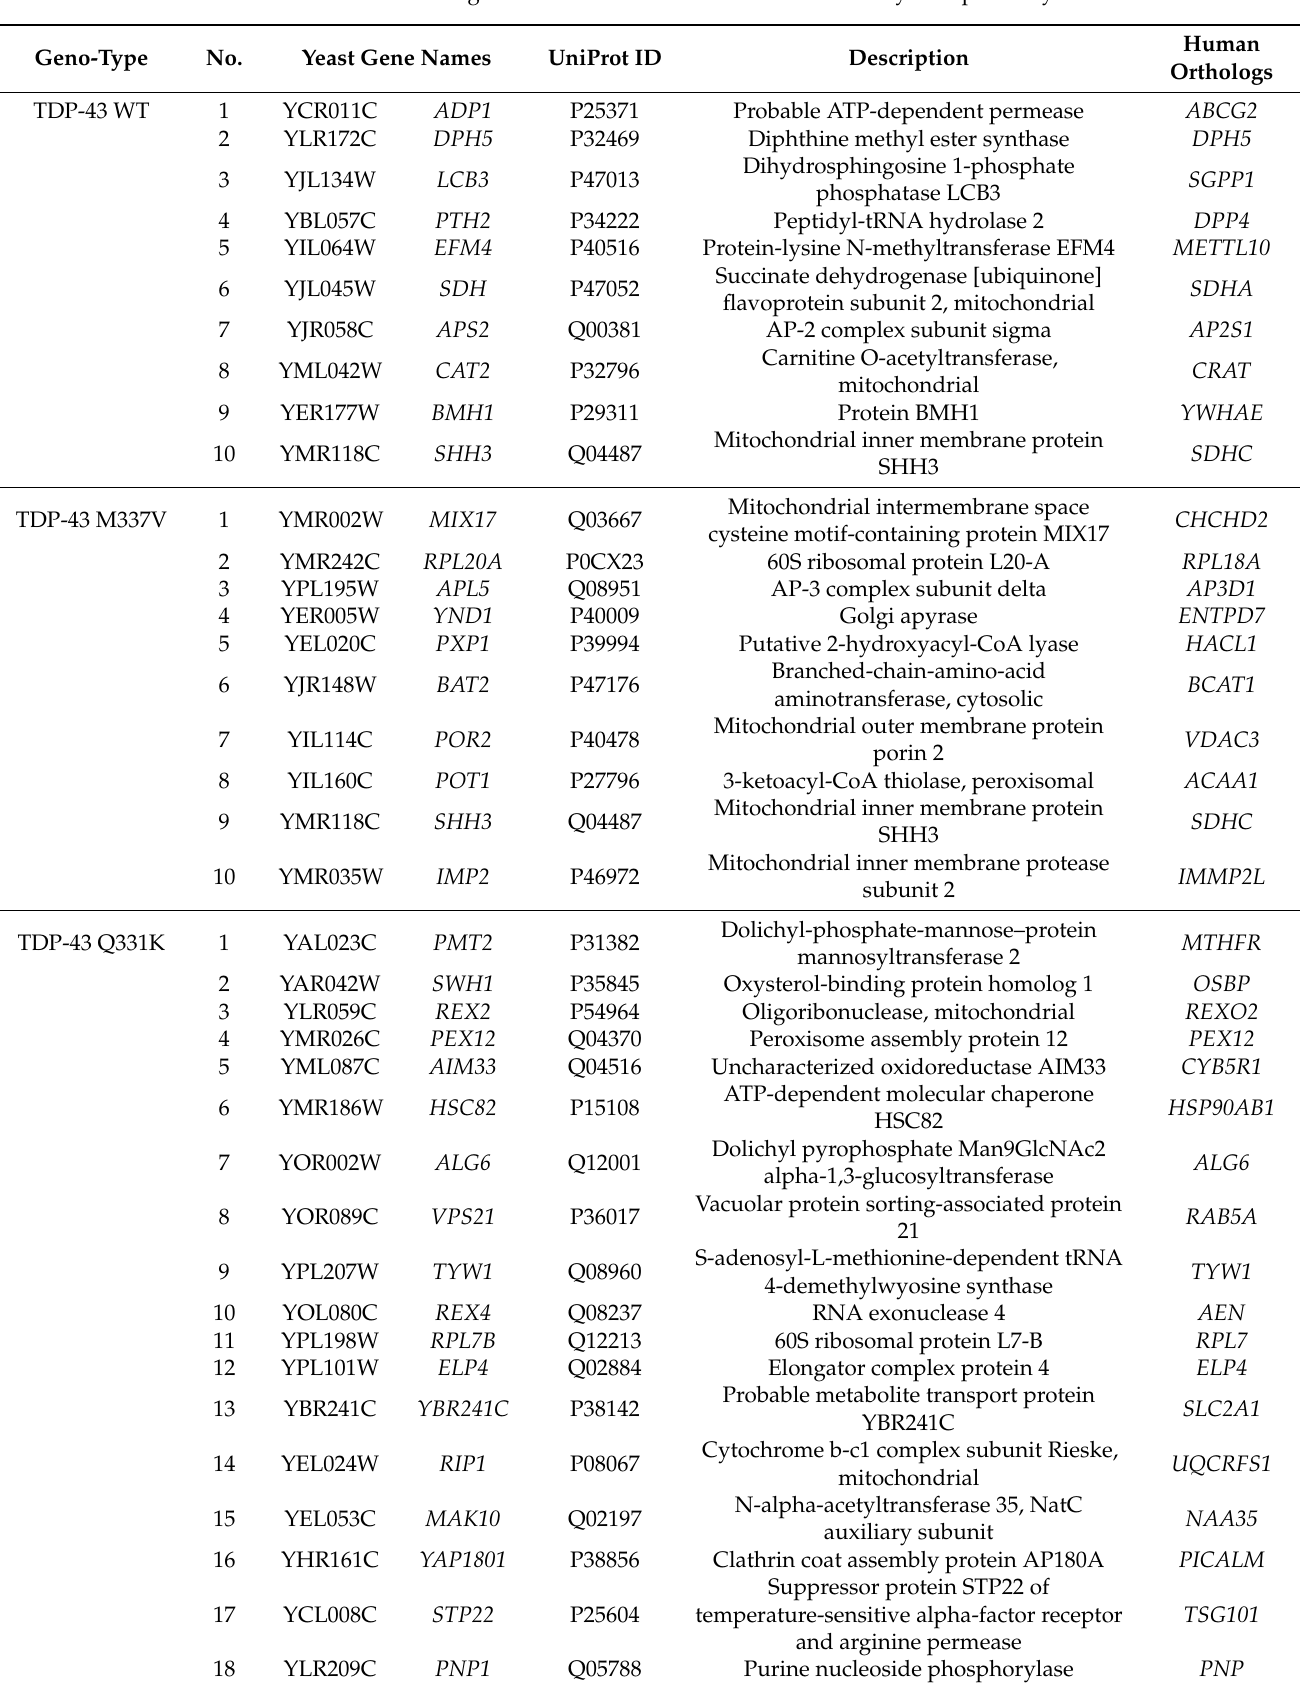
Table 1. List of TDP-43 genetic interaction candidates tested in the yeast spot